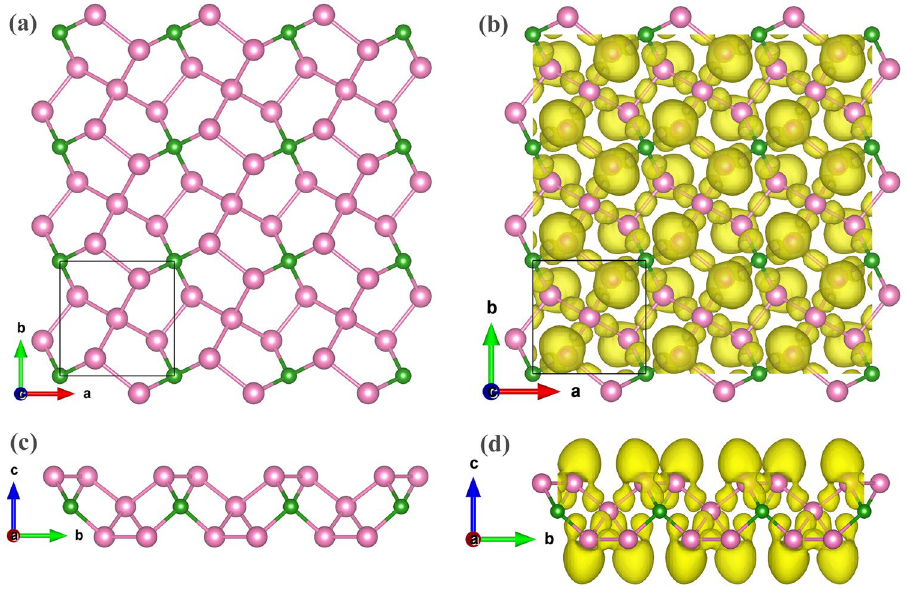
Figure 1. Top and side views of the ( a and c ) predicted structure and ( b and d ) corresponding ELF of penta-BP 5 monolayer. The B and P atoms are denoted by pink and green balls, respectively. The isovalue of the ELF is